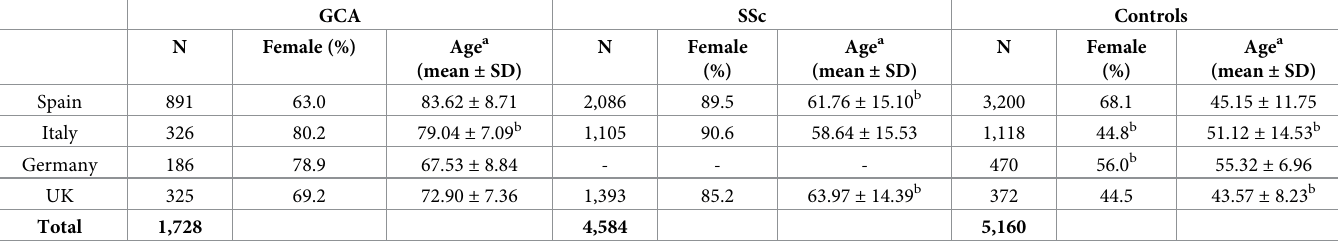
Table 1. Case/control sets included in the present